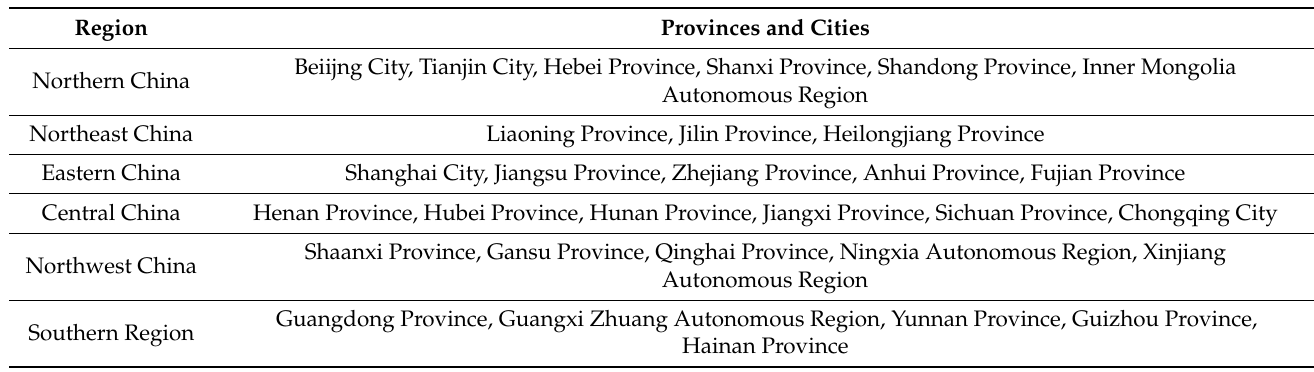
Table 5. Regional division of China’s power grid.